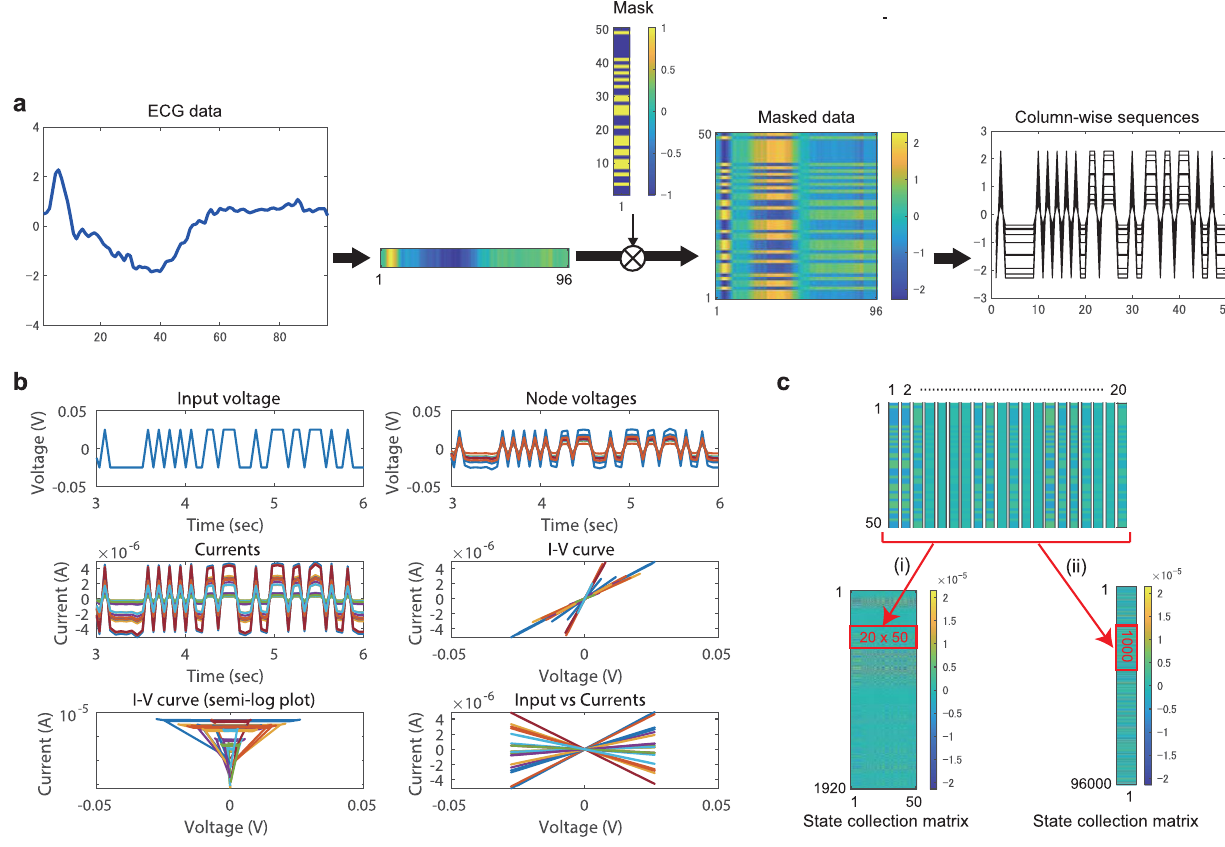
Figure 4. Signal processing for the ECG classification task. ( a ) The preprocessing method. An original ECG data is transformed with a binary mask of + 1 and − 1 into a masked data. Each of the L data (=96) column-wise sequences is fed into the memristive reservoir. ( b ) A dynamic response of the memristive reservoir of the Rand-UP type when ¯ r = 50 and σ = 0.2 . ( c ) The postprocessing method. The N m (= 20) sequences of length L out (= 50) are obtained from the reservoir for each input sequence. In Case (i), the reservoir outputs of size L out × N m are rotated and stacked for all the reservoir inputs to form a state collection matrix. In Case (ii), the reservoir outputs are transformed into a one-dimensional sequence and concatenated for all the reservoir inputs to form a state collection